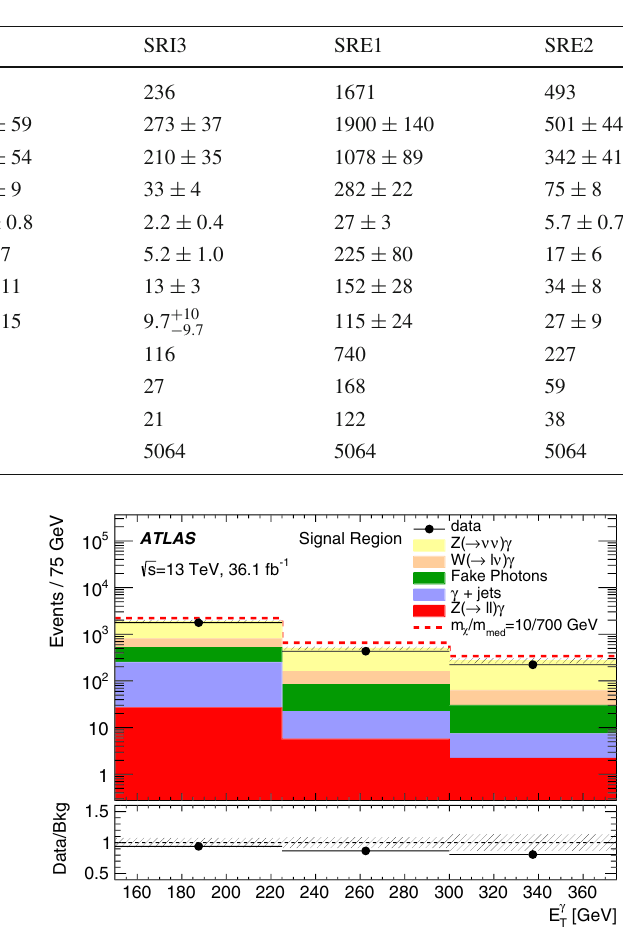
the dominant backgrounds allows to partially cancel some systematic uncertainties (see Sect. 8 for more details). The individual uncertainties can be correlated and do not necessarily add in quadrature to equal the totalbackgrounduncertainty.Theobservednumberofeventsinthefour CRs relative to each SR is also shown. The total fitted background does not match exactly the sum of the individual contributions because of